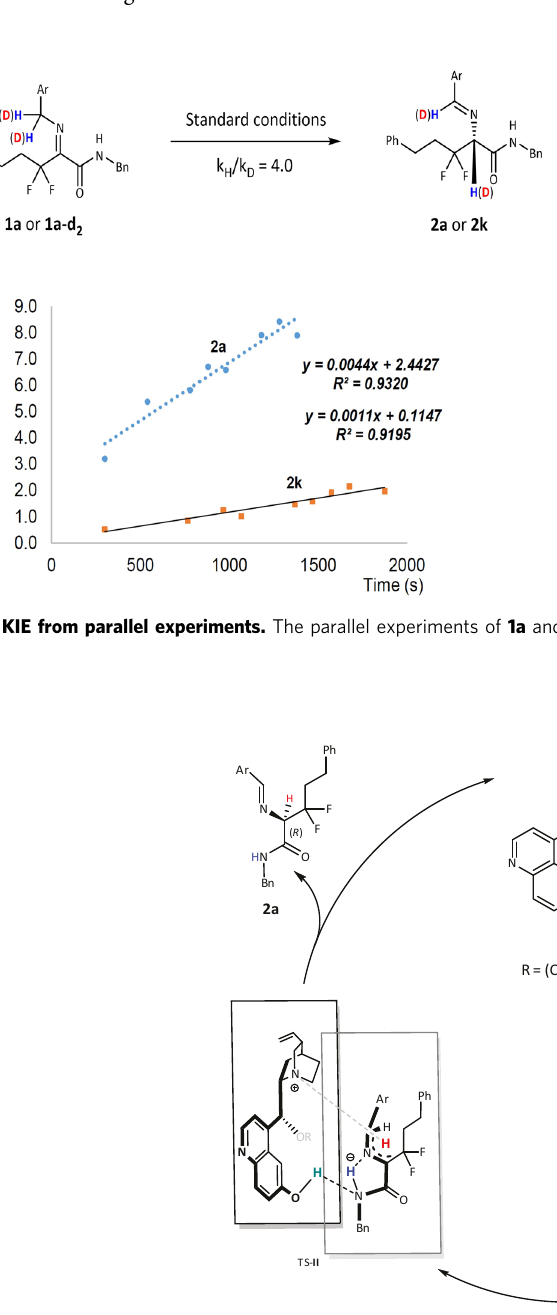
Fig. 6 Proposed transition model. The possible mechanistic of the enantioselective [1,3]-proton-shift